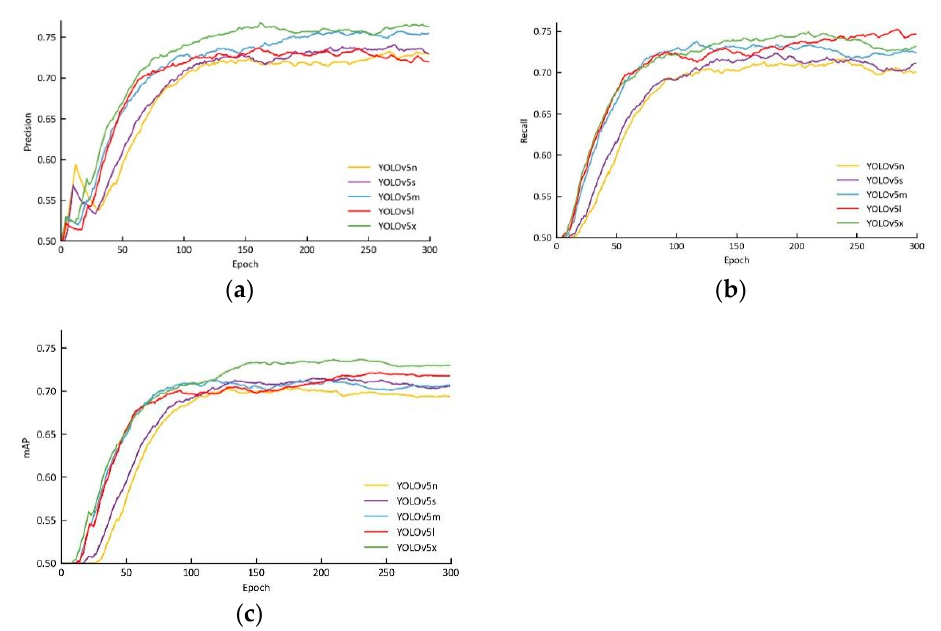
Figure 7. Comparison of different YOLOv5 models. ( a ) Precision curve; ( b ) Recall curve; ( c ) mAP curve. Table 3. Test results of leaf detection with different YOLOv5.